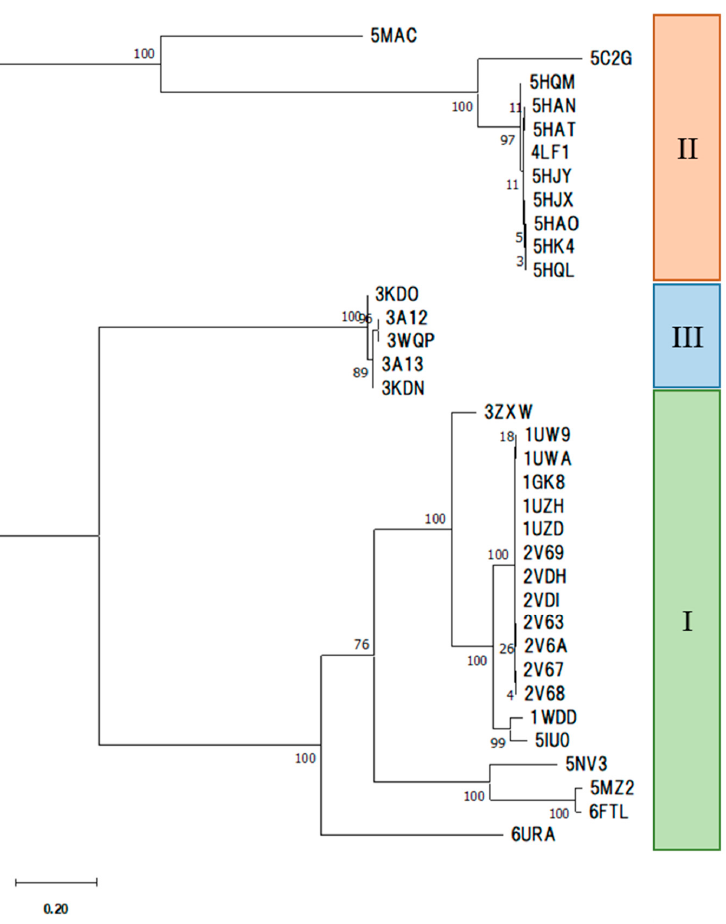
Figure 4. Phylogenetic tree of RuBisCOs obtained through multiple alignment of amino acid se- quences. The corresponding PDB entries are shown along with their isoform (I–III) specification.